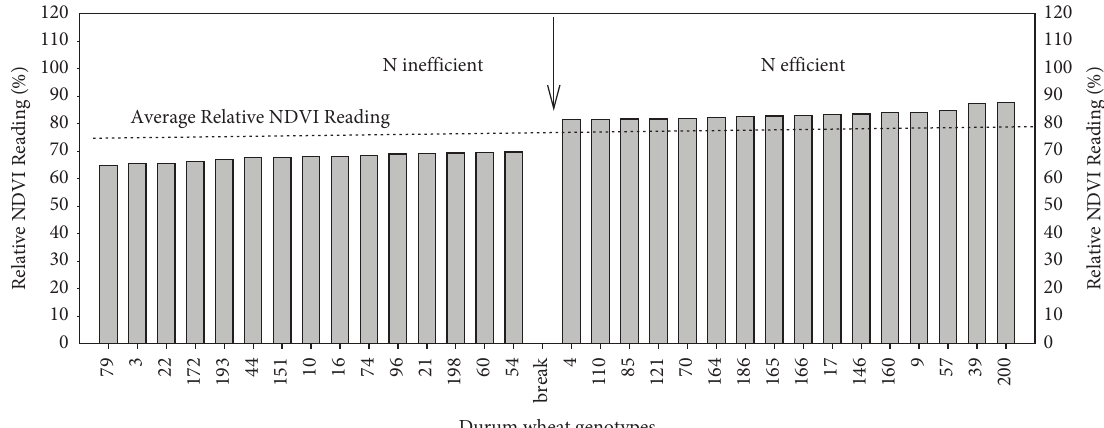
Figure 6: Categorization of N-efcient and inefcient genotypes based on relative NDVI reading (only the 15 most extreme genotypes from each efcient and inefcient category were mentioned in the abovementioned fgure due to limited space to accommodate all; the break is the demarcation between N-efcient and inefcient